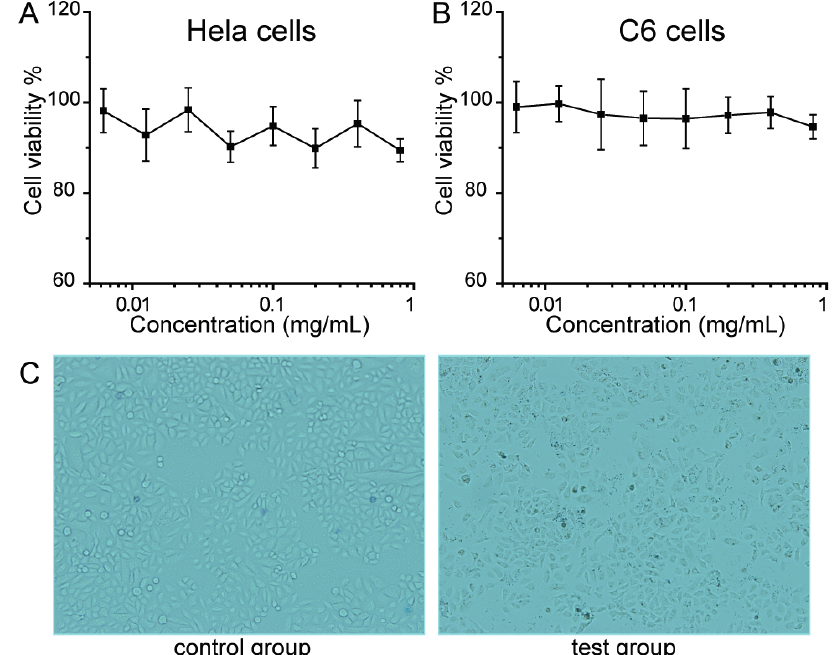
Figure 4. Viability of different cell lines: Hela cells ( A ) and C6 cells ( B ); ( C ) Bright field microscopic images of C6 cells, the control group and test group are incubated without and with PEG–Fe 3 O 4 , respectively. Cell images are observed under a light microscope at 1000×